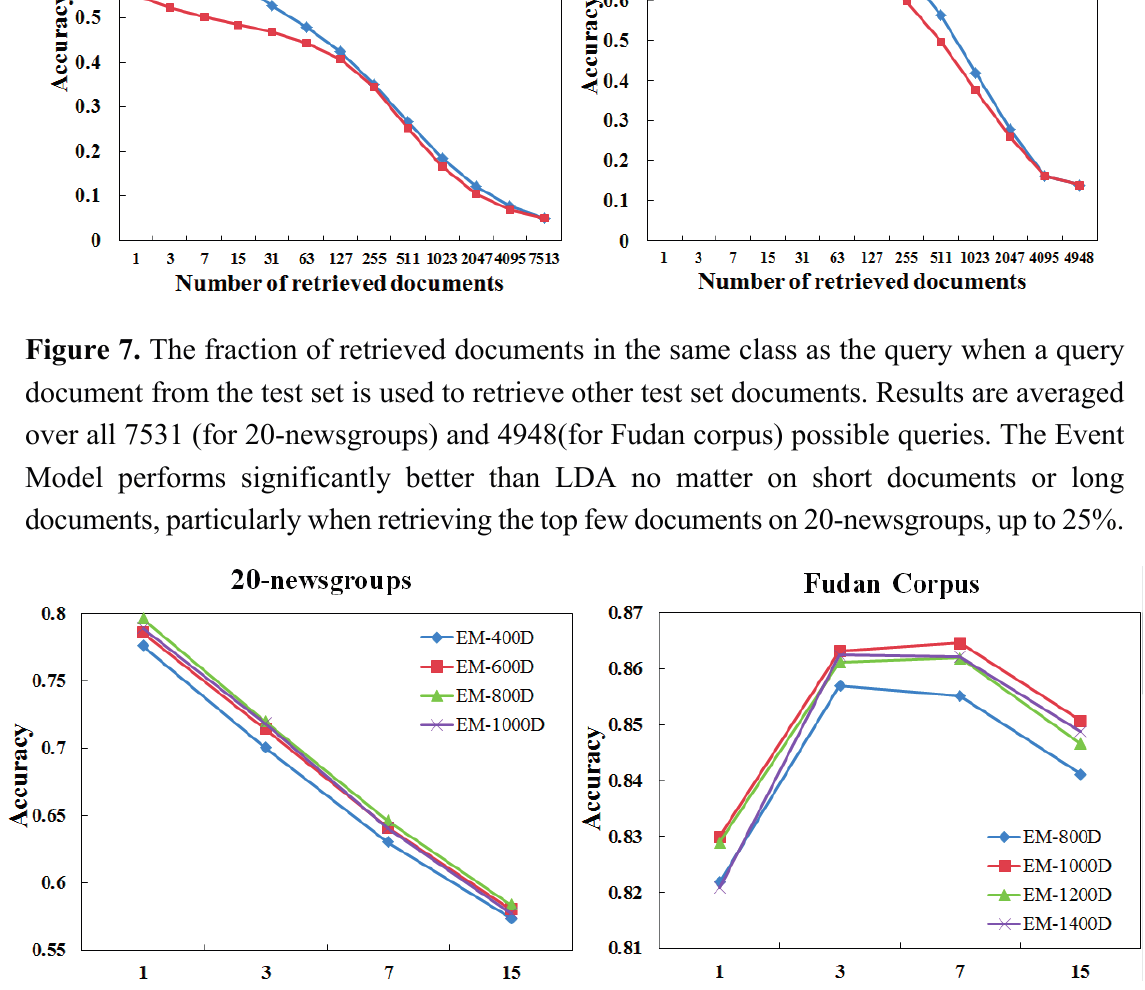
Figure 8. The effect of parameter N on retrieval performance for Event Model. N can be changed in very large ranges (400 to 1000 for 20-newsgroups and 800 to 1400 for Fudan Corpus), which means that the degree of semantic relatedness between words in the same word class has small influence on retrieval